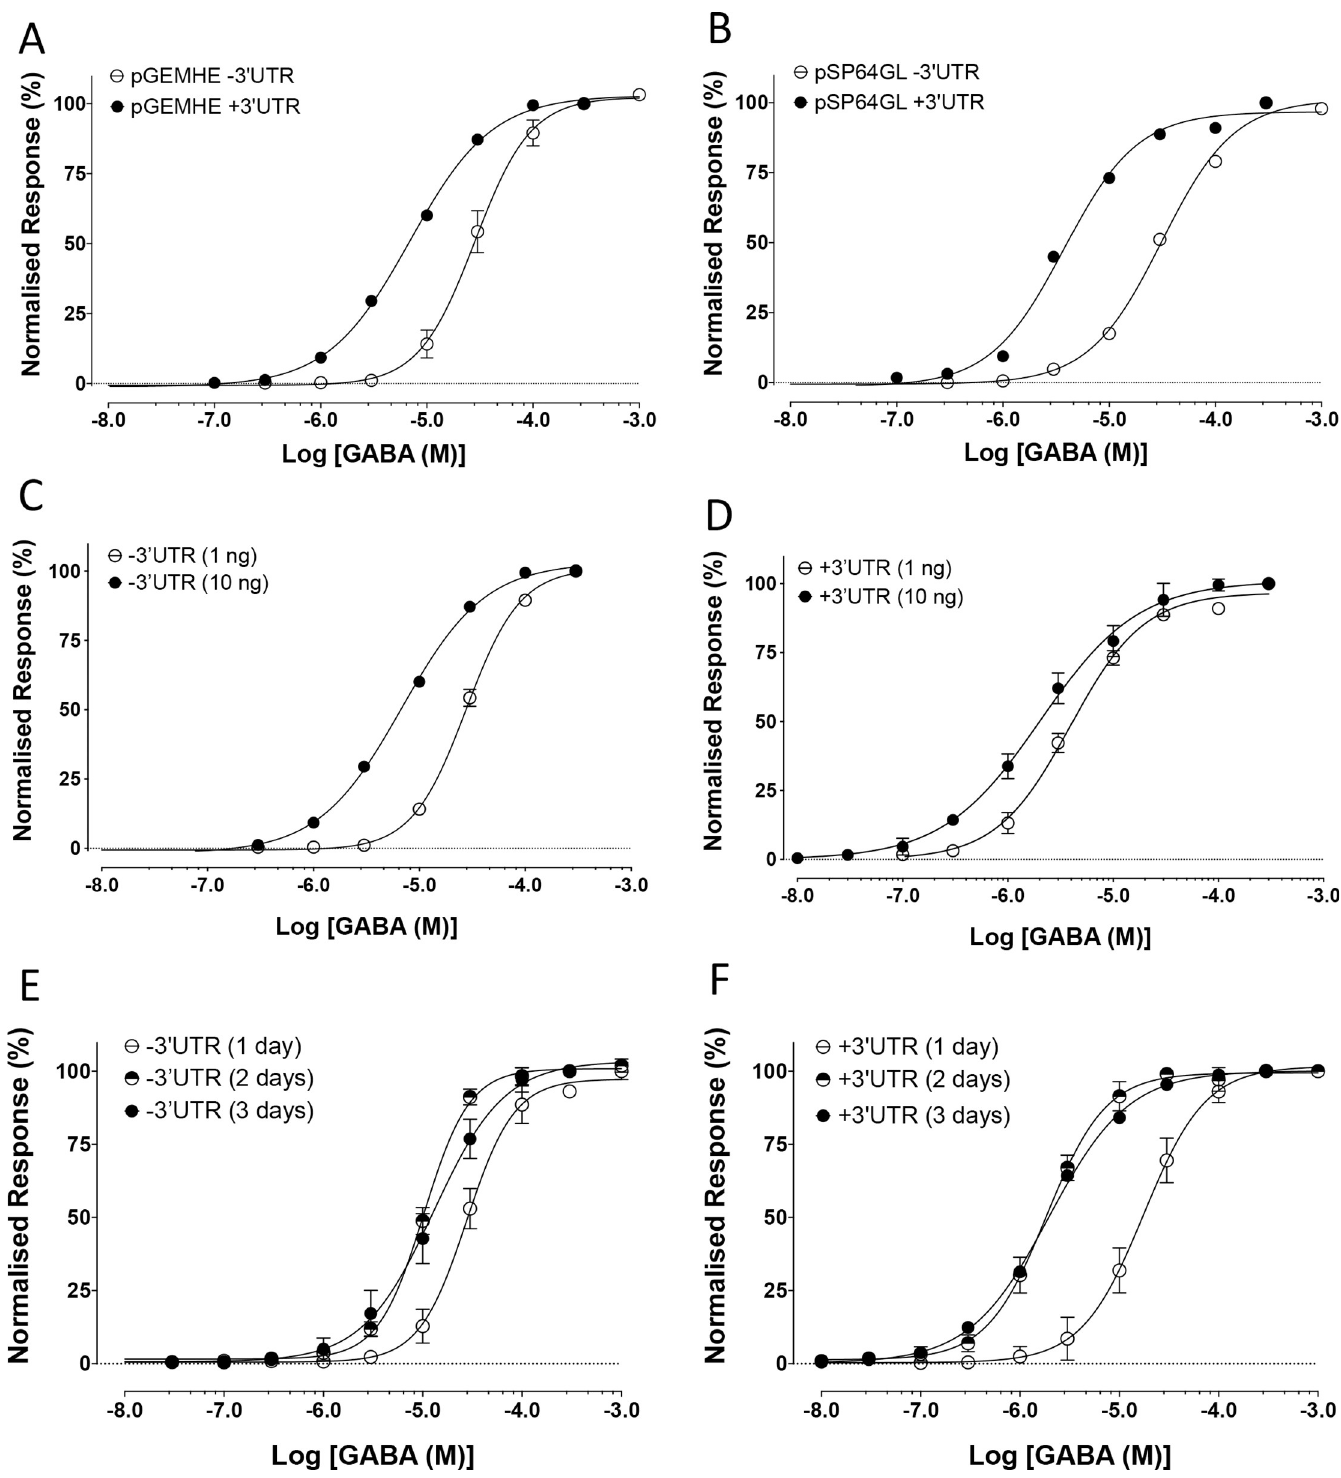
Fig 2. Changes in apparent affinity for GABA associated with differences in expression condition of BtRDL in Xenopus oocytes. A) GABA dose-responses curves from oocytes injected with cRNA synthesised from pGEMHE-BtRDL after digestion with Xba I to remove the 3’UTR (open circles) and from pGEMHE-BtRDL after digestion with Nhe I to retain the 3’UTR (filled circles). Oocytes were injected with 1 ng cRNA and recorded three-days post-injection. B) GABA dose-responses curves from oocytes injected with cRNA synthesised and pSP64GL-BtRDL after digestion with Not I to remove the 3’UTR (open circles) and from pSP64GL-BtRDL after